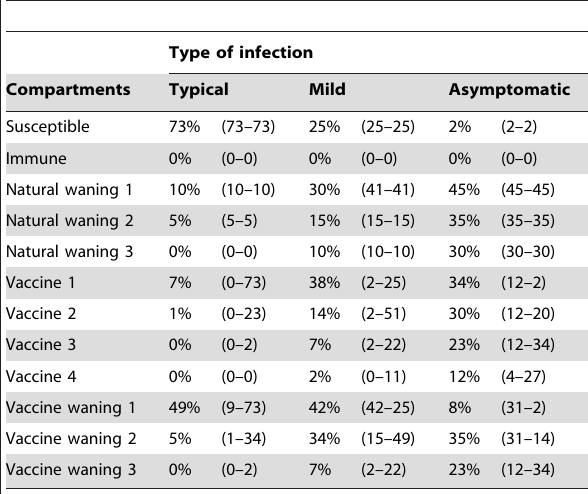
Table 1. Distribution of outcomes in case of